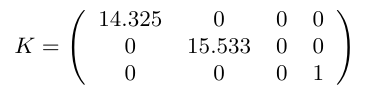
Figure 6. Orthographic projection model of a real object into the image plane.